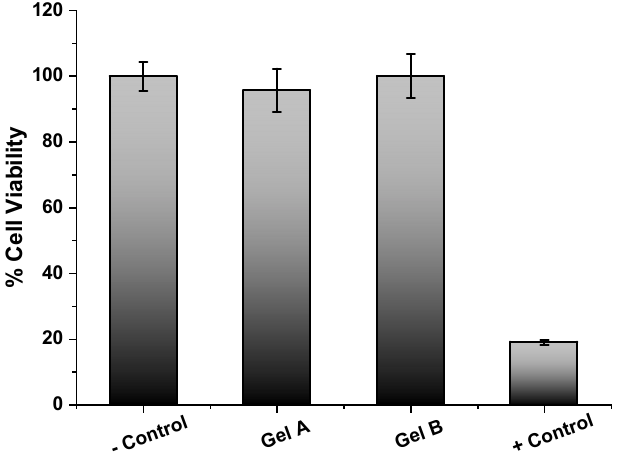
Figure 6. Cytotoxicity assessment of the prototype formulations. MTS dye absorbance was assessed at λ = 490 nm. Control − corresponded to cells without any treatment, whereas Control + corresponded to cells incubated with 100% dimethyl